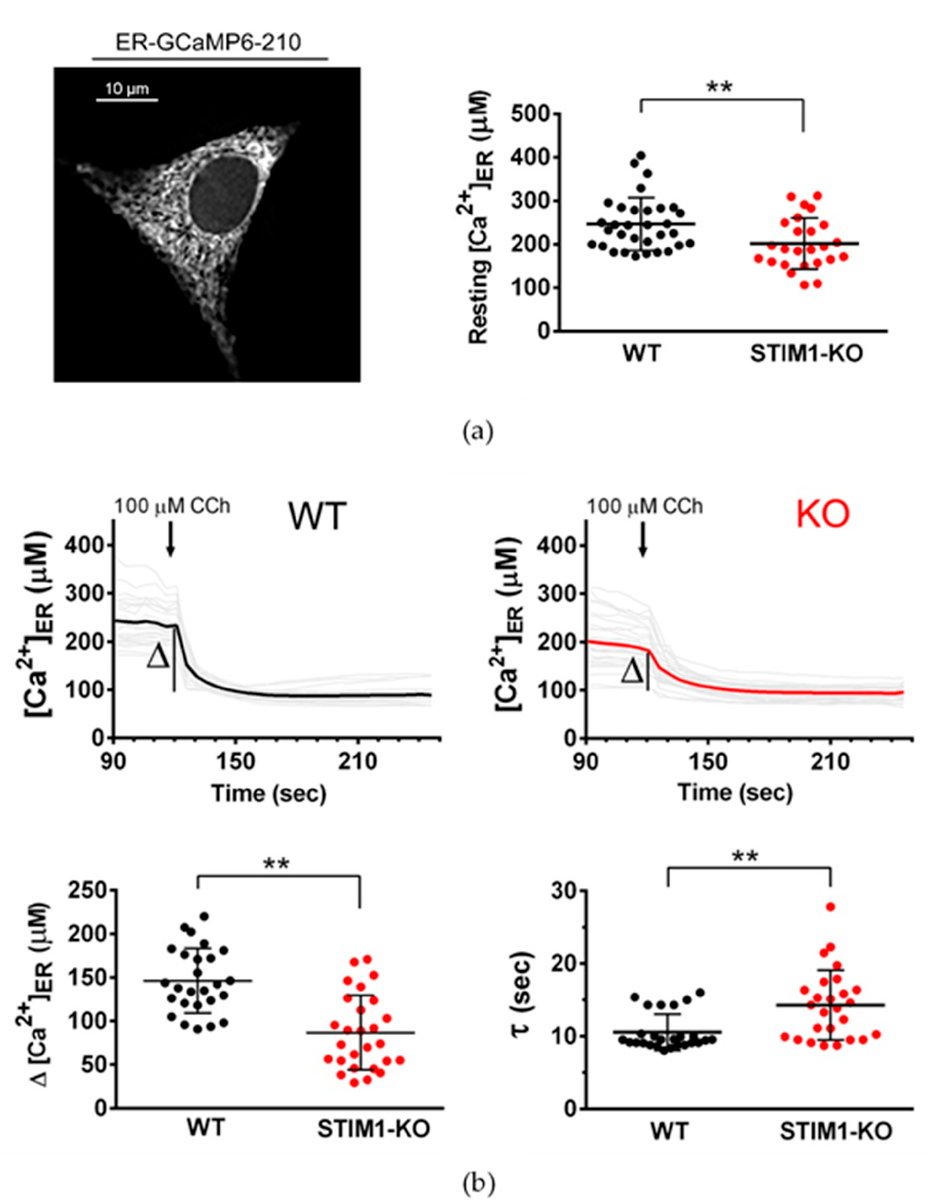
Figure 3. Free Ca 2 + concentration within the endoplasmic reticulum (ER) and Ca 2 + release triggered by CCh. ( a ) The ER-specific Ca 2 + sensor ER-GCaMP6-210 was used to measure steady-state levels of [Ca 2 + ] ER in undi ff erentiated SH-SY5Y cells. The figure shows the distribution of the sensor under excitation wavelength with 480 nm (Emission = 510 nm). Forty-eight hours after transfection, the [Ca 2 + ] ER was evaluated for cells incubated in Ca 2 + -containing HBSS. Data are mean ± S.D. from 2 independent experiments (n = 32 ROIs from 13 WT cells, and n = 25 ROIs from 13 KO cells). ( b ) Transfected cells with ER-GCaMP6-210 were stimulated with 100 µ M CCh and the amplitude of the decrease in [Ca 2 + ] ER and time constant tau ( τ ) of the kinetics of [Ca 2 + ] ER in response to CCh were calculated. Data are mean ± S.D. from 13 cells and 26 ROIs per experimental condition. (**) Statistical significance p <